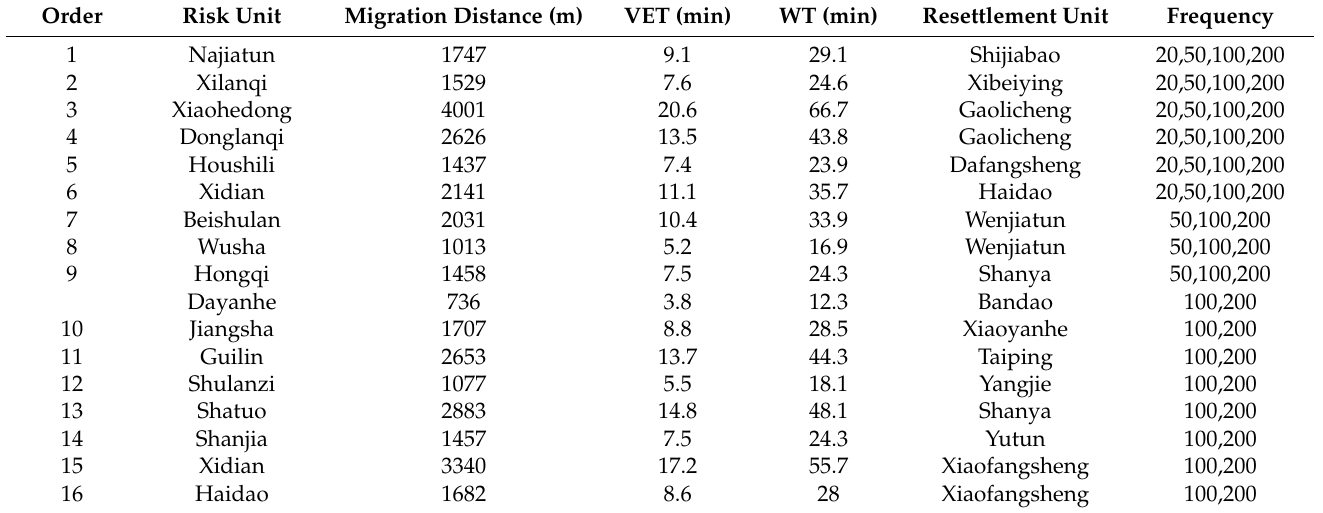
Table 3. Information of Emergency